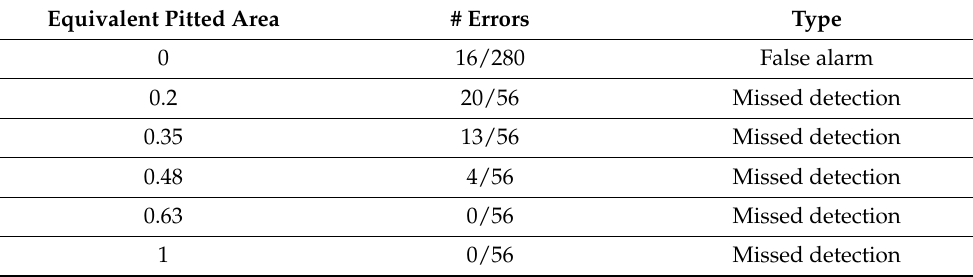
Table 5. Detailed detection ANN performance.